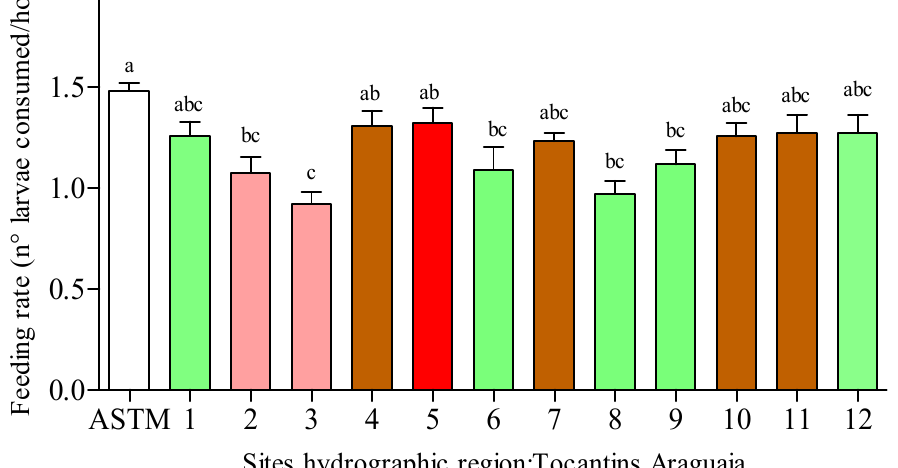
Sites hydrographic region:Tocantins Araguaia Figure 2. Feeding rate (number of C. xanthus larvae consumed per hour) of G. tigrina after 96 h Figure 2. Feeding rate (number of C. xanthus larvae consumed per hour) of G. tigrina after 96 h expo- Figure 2. Feeding rate (number of C. xanthus larvae consumed per hour) of G. tigrina after 96 h exposure with water samples from Tocantins-Araguaia Sites Hydrographic Region: Lagoa da Con- Figure 2. Feeding rate (number of C. xanthus larvae consumed per hour) of G. tigrina after 96 h Figure 2. Feeding rate (number of C. xanthus larvae consumed per hour) of G. tigrina after 96 h Figure 2. Feeding rate (number of C. xanthus larvae consumed per hour) of G. tigrina after 96 h sure with water samples from Tocantins-Araguaia Sites Hydrographic Region: Lagoa da Confus ã o exposure with water samples from Tocantins-Araguaia Sites Hydrographic Region: Lagoa da Con- fusão (1–3); Formoso do Araguaia (4–6); Porto Nacional (7–9); Gurupi (10–12); Reference (12). A exposure with water samples from Tocantins-Araguaia Sites Hydrographic Region: Lagoa da Con- exposure with water samples from Tocantins-Araguaia Sites Hydrographic Region: Lagoa da Con- exposure with water samples from Tocantins-Araguaia Sites Hydrographic Region: Lagoa da Con- (1–3); Formoso do Araguaia (4–6); Porto Nacional (7–9); Gurupi (10–12); Reference (12). A laboratory fusão (1–3); Formoso do Araguaia (4–6); Porto Nacional (7–9); Gurupi (10–12); Reference (12). A laboratory control with ASTM only was also used to expose planarians. Values represent the mean fusão (1–3); Formoso do Araguaia (4–6); Porto Nacional (7–9); Gurupi (10–12); Reference (12). A fusão (1–3); Formoso do Araguaia (4–6); Porto Nacional (7–9); Gurupi (10–12); Reference (12). A fusão (1–3); Formoso do Araguaia (4–6); Porto Nacional (7–9); Gurupi (10–12); Reference (12). A control with ASTM only was also used to expose planarians. Values represent the mean ( ± SEM), laboratory control with ASTM only was also used to expose planarians. Values represent the mean (± SEM), n = 10. Different letters indicate significant differences between study sites when p < 0.05. laboratory control with ASTM only was also used to expose planarians. Values represent the mean laboratory control with ASTM only was also used to expose planarians. Values represent the mean laboratory control with ASTM only was also used to expose planarians. Values represent the mean n = 10. Different letters indicate significant differences between study sites when p < 0.05. Colors (± SEM), n = 10. Different letters indicate significant differences between study sites when p < 0.05. Colors used in graph bars are associated with analysis of water performed: very high concen- (± SEM), n = 10. Different letters indicate significant differences between study sites when p < 0.05. (± SEM), n = 10. Different letters indicate significant differences between study sites when p < 0.05. (± SEM), n = 10. Different letters indicate significant differences between study sites when p < 0.05. used in graph bars are associated with analysis of water performed: very high concentrations, Colors used in graph bars are associated with analysis of water performed: very high concen- trations, high concentrations, above acceptable limits, acceptable limit. Colors used in graph bars are associated with analysis of water performed: very high concen- Colors used in graph bars are associated with analysis of water performed: very high Colors used in graph bars are associated with analysis of water performed: very high concen- trations, high concentrations, above acceptable limits, acceptable limit. trations, high concentrations, above acceptable limits, acceptable limit. above acceptable limits, trations, high concentrations, above acceptable limits, acceptable limit.